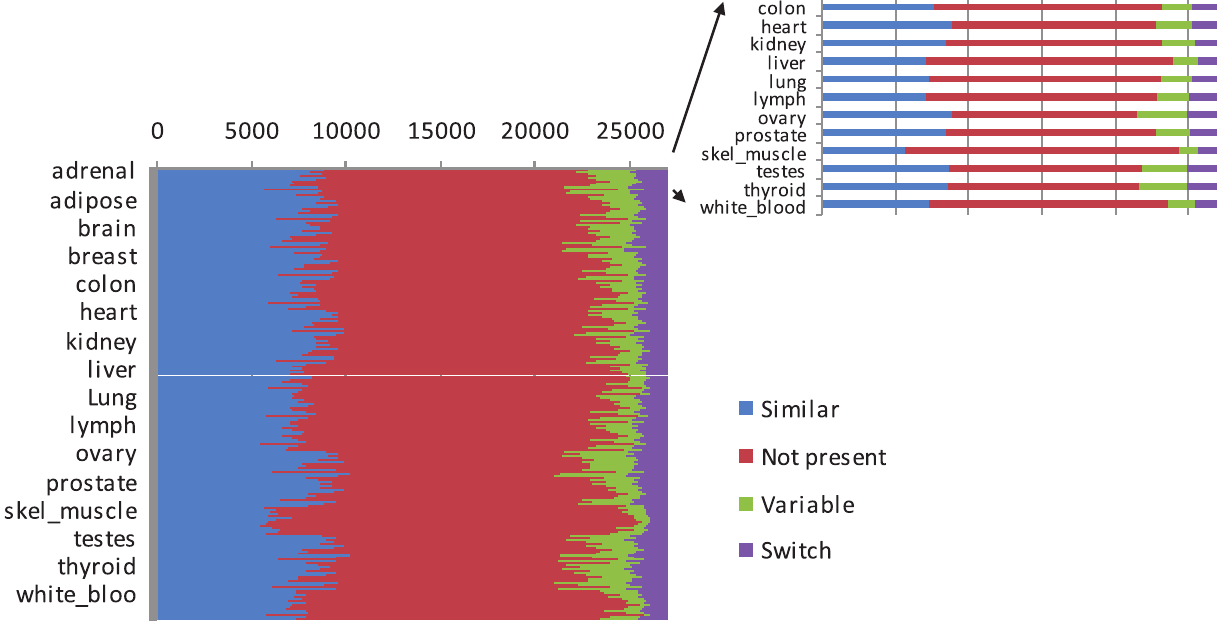
Figure 4. Splicing patterns for the 26,989 exon skipping events are compared between any two tissues, and events are classified by the difference in the splicing ratios. The 255 x 255 matrix shows the dynamics of exon skipping events between a tissue and each of the others. The numbers of similar (blue), variable (green), switch (purple) and not present (red) events between any two tissues are shown along one